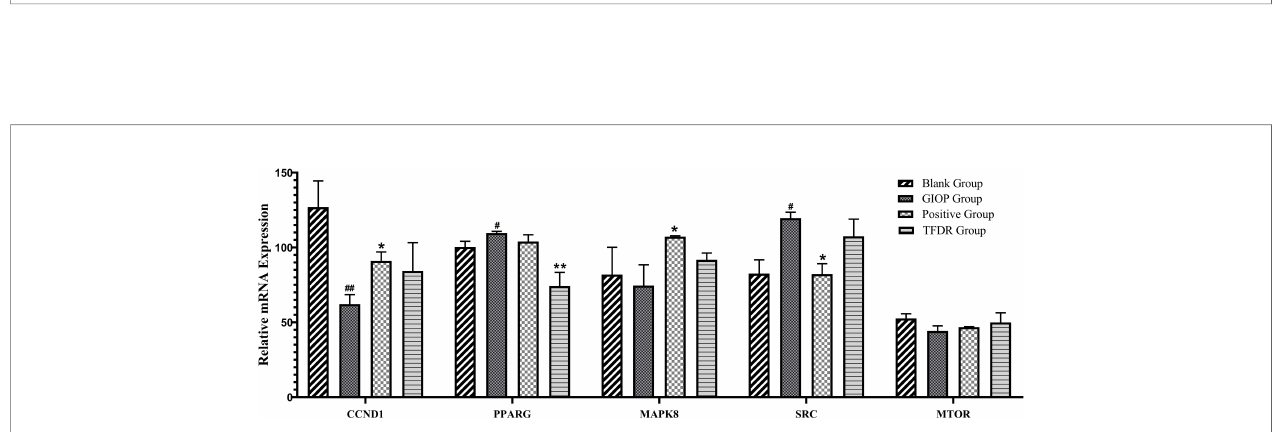
FIGURE 12 | The mRNA expression levels of 6 core targets. Data are expressed as mean ± SEM. *p < 0.05 and **p < 0.01 vs. GIOP group rats; # p < 0.05 and ## p < 0.01 vs. blank group rats.